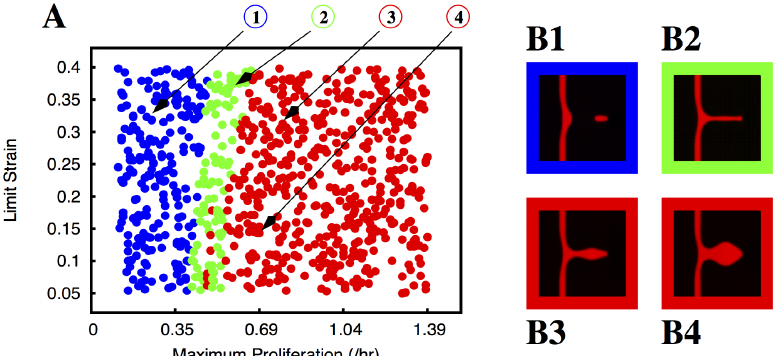
Fig 5. Morphology of the growing sprouts with endothelial cell proliferation dependent on local strain but triggered by VEGF. In plate A we indicate the morphology of the growing sprout (by using different colours) for different values of maximum proliferation ( M P ) and limit strain ( L S ). In these simulations the proliferation rate increases linearly with the strain until it reaches its maximum value M P at the strain L S , but is only different from zero where the concentration of angiogenic factor is larger than a cut-off, i.e. V > V m = 0.05. The colours indicate the morphology of the observed sprouts for the corresponding parameters: blue dots correspond to situations where the sprout breaks, the red dots correspond to deformed vessels (vessels with variable thickness in this case), and the green dots correspond to well formed sprouts without appreciable thickening of the parental vessel. We observe that the sprout breaks for low proliferation rates, and it becomes deformed for large proliferation rates; the region of parameters that produce good sprouts is localised in a narrow vertical band. In plates B1, B2, B3 and B4 we plot examples of the morphologies observed (the color of the border in these plates follows the same code as in plate A). The parameters used to obtain the morphologies depicted in B1, B2, B3 and B4 are indicated by arrows in plate A.